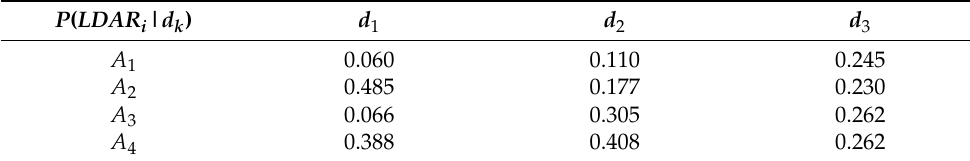
Table 5. The value of conditional probabilities of individual regret of d k